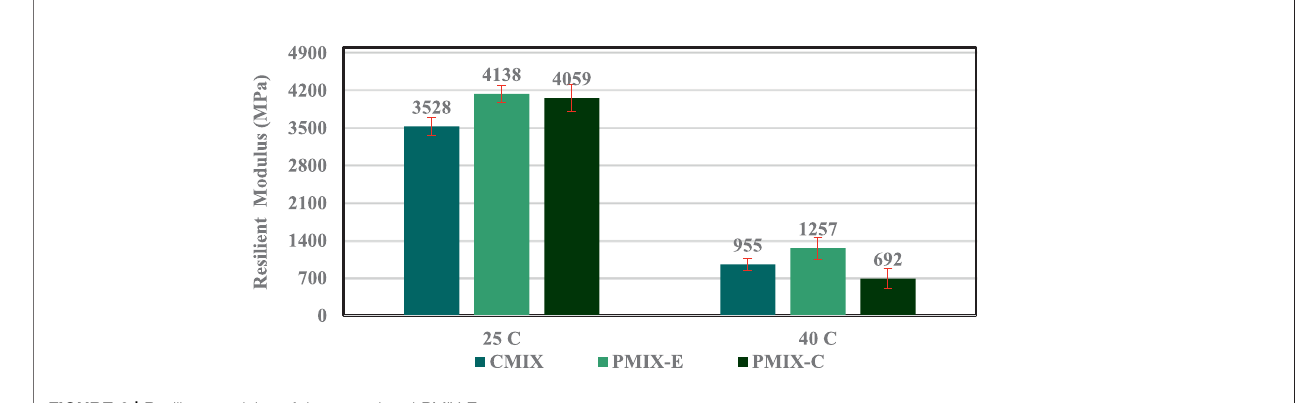
FIGURE 6 | Resilient modulus of the control and PMIX-E